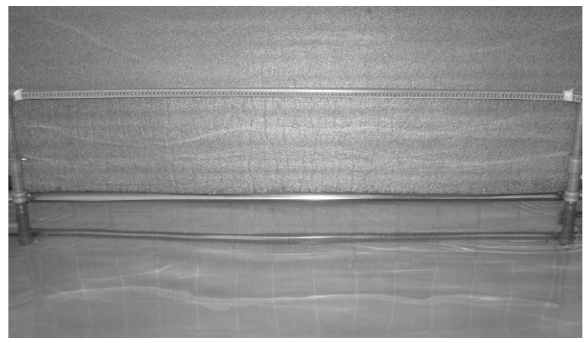
Figure 2 - Tape measure